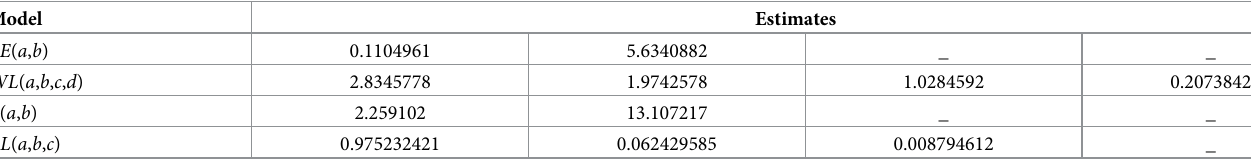
Table 1. Maximum likelihood estimates for data set 1.